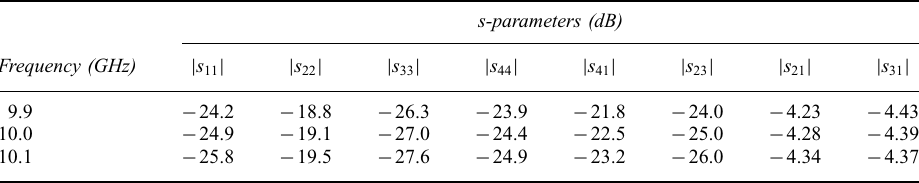
TABLE IV Exact Values of All s -parameters of the Final 180-deg Coupler Design at the Desired Frequency. s-parameters (dB)